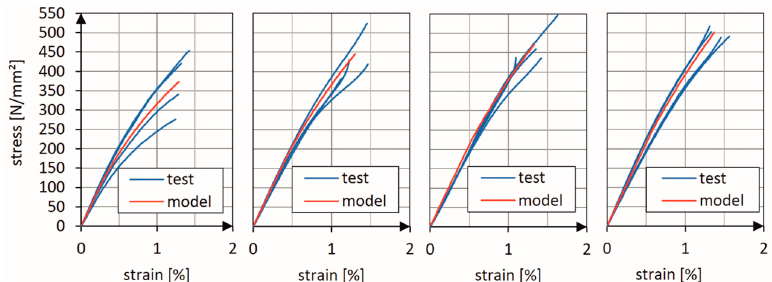
Figure 5. Comparison of measured and predicted stress-strain curves for material configuration (a), layup: 4 layers ±45° with 0° filler yarn (2D triaxial braid), for four different strain rates: 2 mm/min, 10 mm/s, 100 mm/s and 1000 mm/s (from left to right).